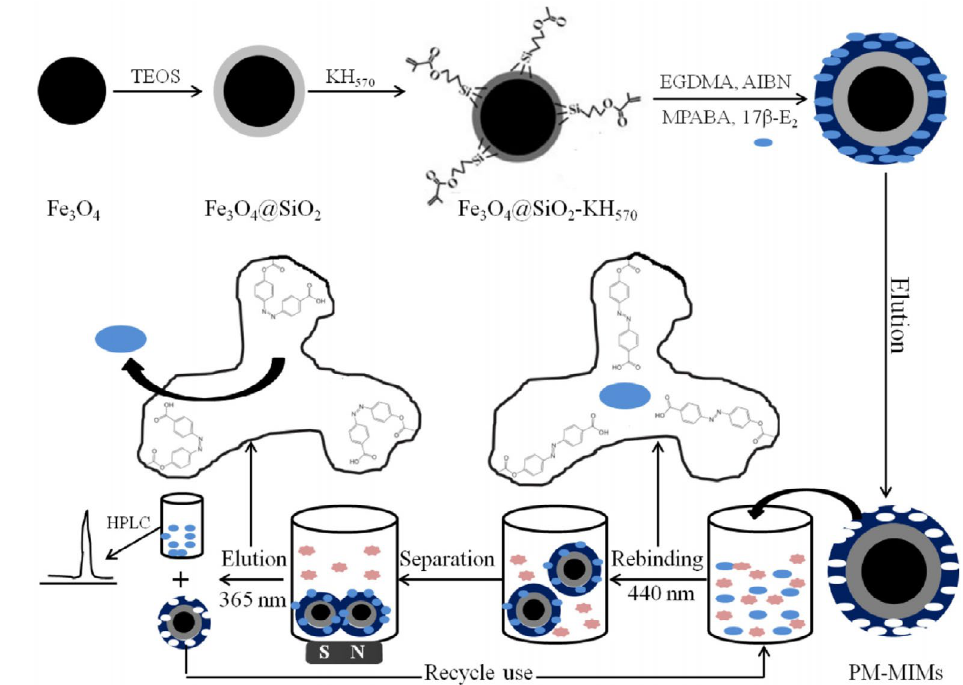
Fig. 10. Schematic illustration for the preparation process of the PM-MIMs, possible mechanism of photoregulated uptake and release and the extraction procedure [80].